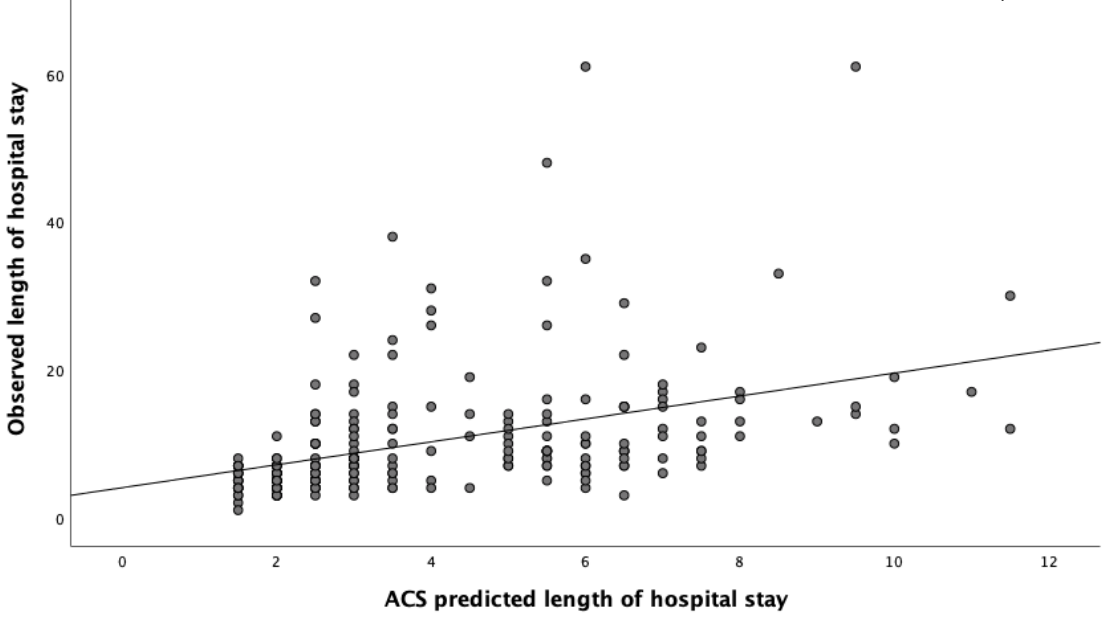
r = 0.264, p = <0.0001